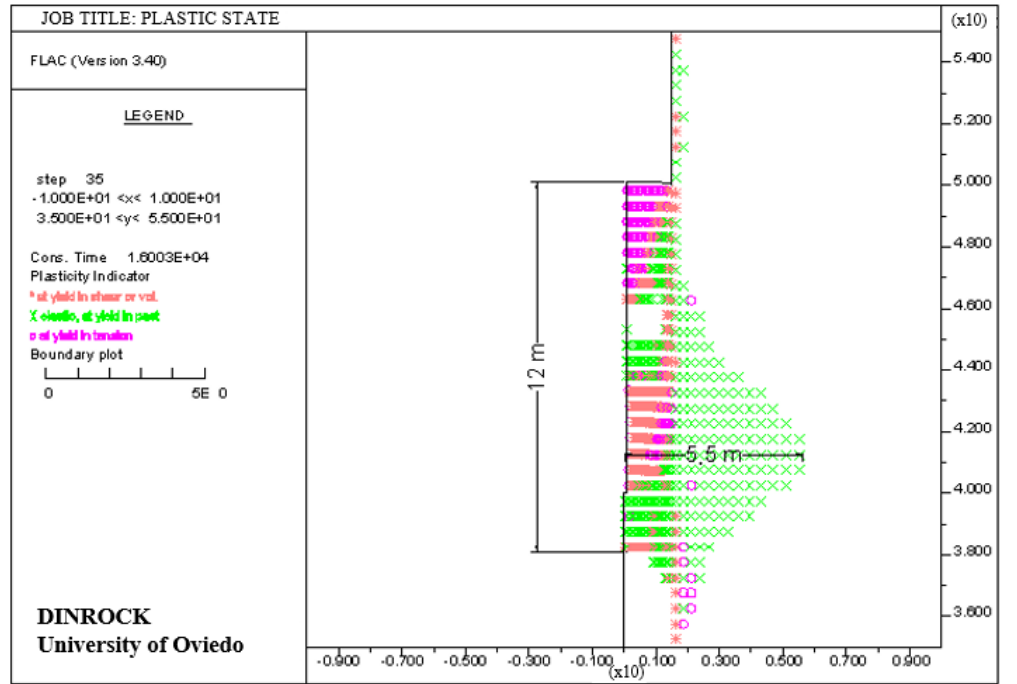
Figure 12. Plastic state of the model with permeability 0.002 mD.